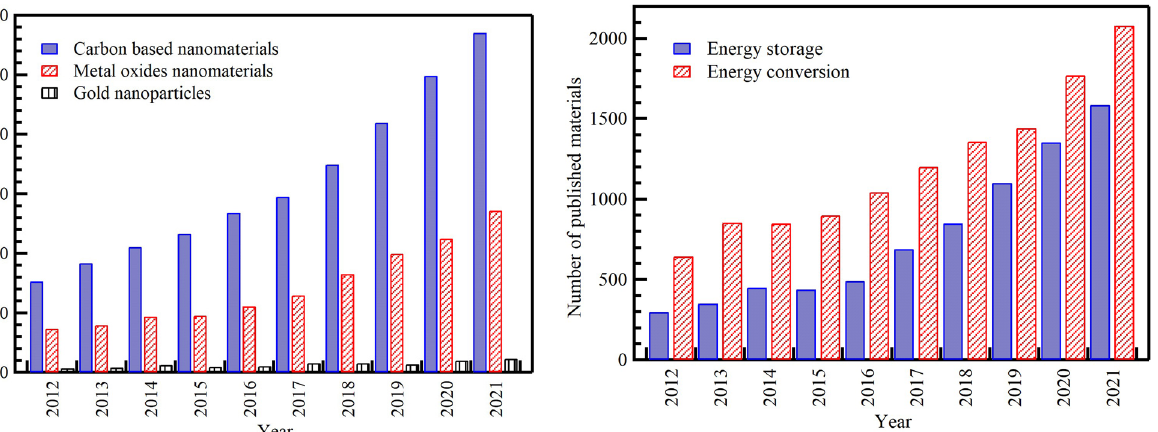
Figure 2: Distribution of the cumulative number of publications on waste - derived NP applications per year from the Scopus database (